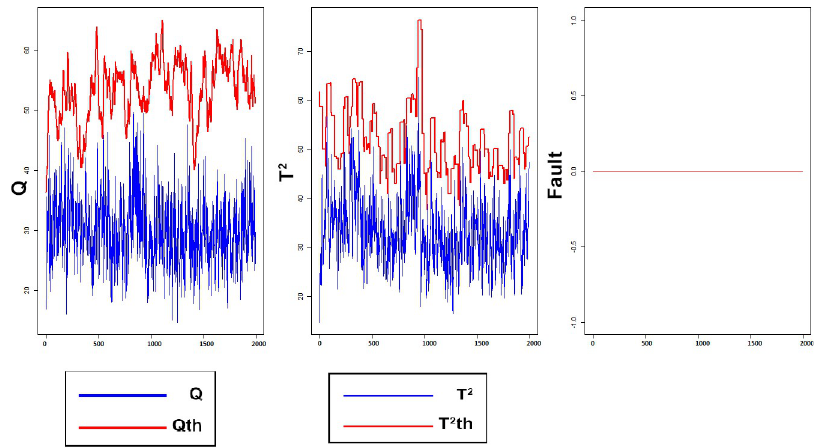
Fig 7. Monitoring performance of MWDPCA for normal process.